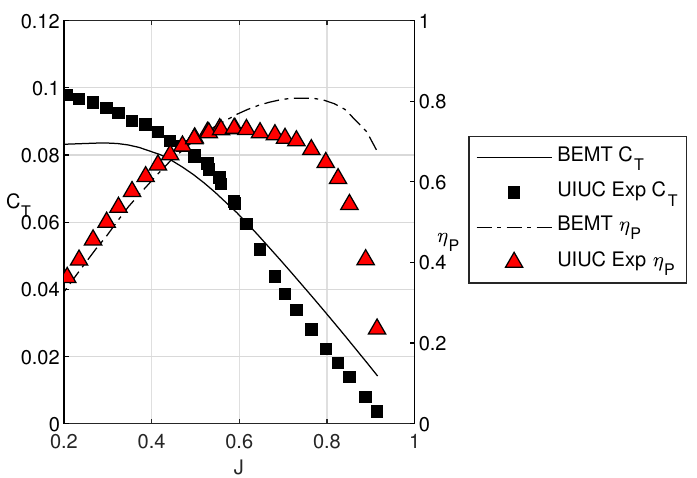
Figure 12. BEMT and UIUC C T , η P of a 14 × 12E APC propeller at 3500 RPM